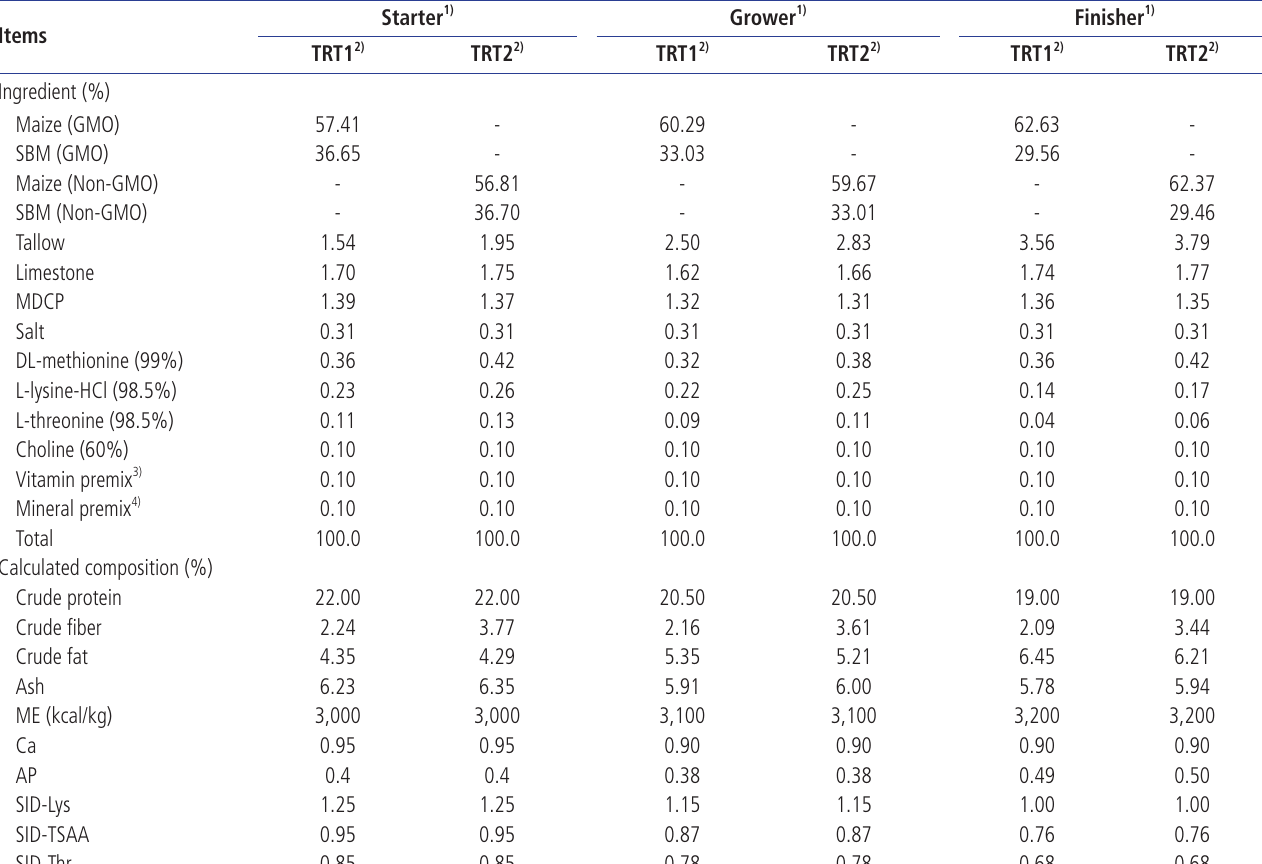
Table 4. Basal diet composition (as-fed basis)